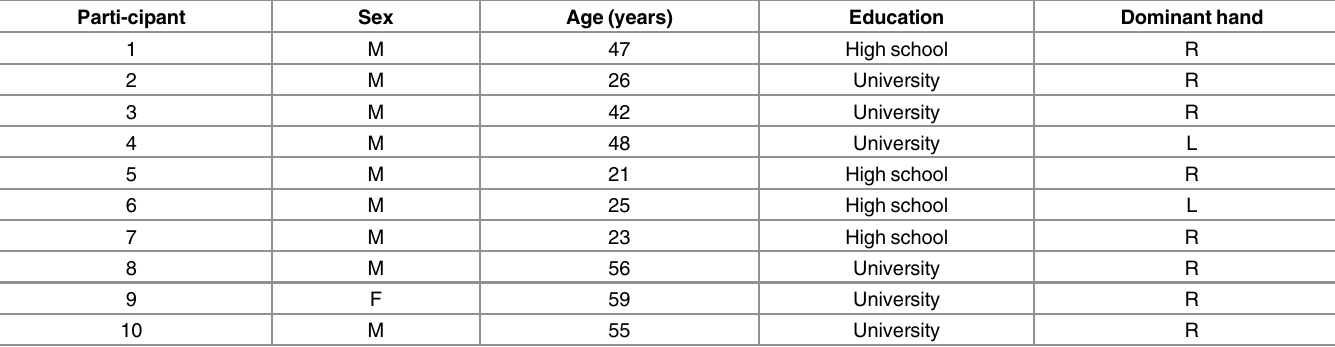
Table 2. Control group: Demographic